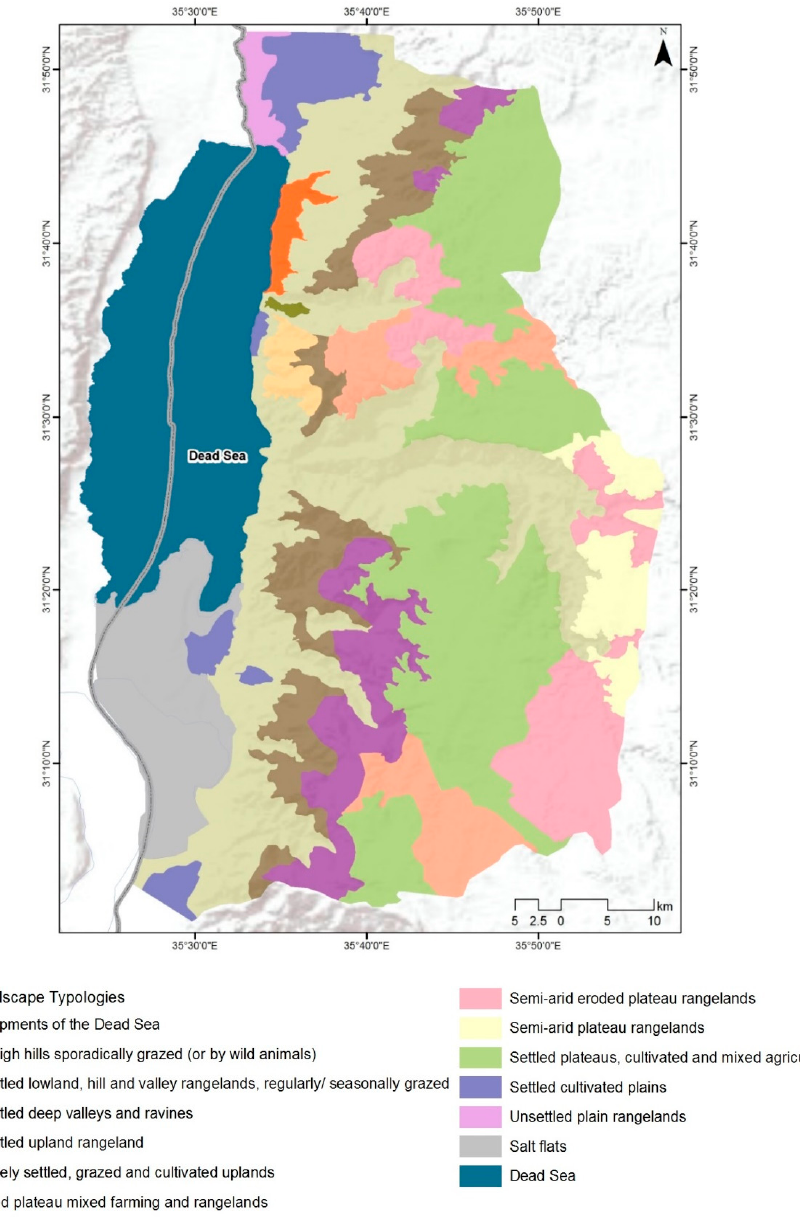
Figure 6. The 14 Typological units in the study area of Wadi Mujib. The numbers of units are well distributed in all the directions in this study area.